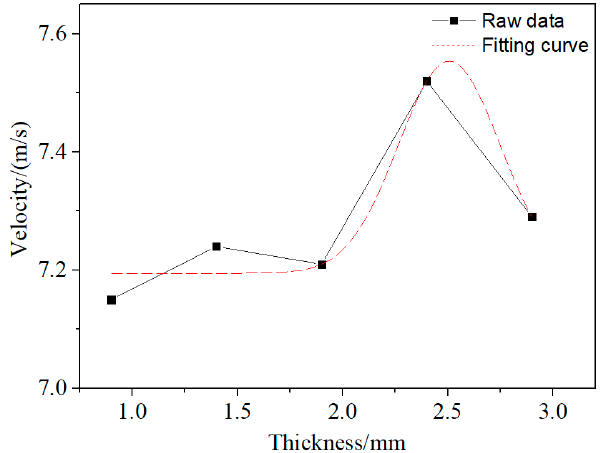
Figure 9. Variation curve of the continuous velocity of the explosive charge jet with the wall thickness